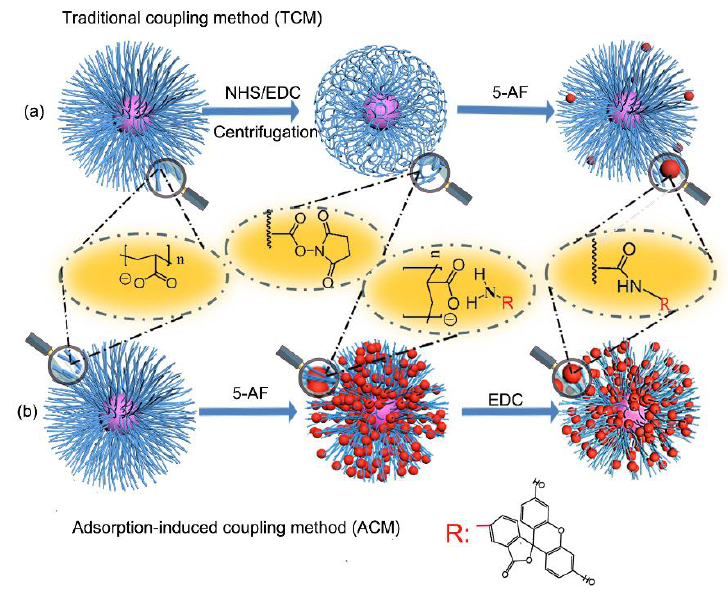
Figure 2. ( a ) The fluorescence intensity of HFNs by different coupling methods in